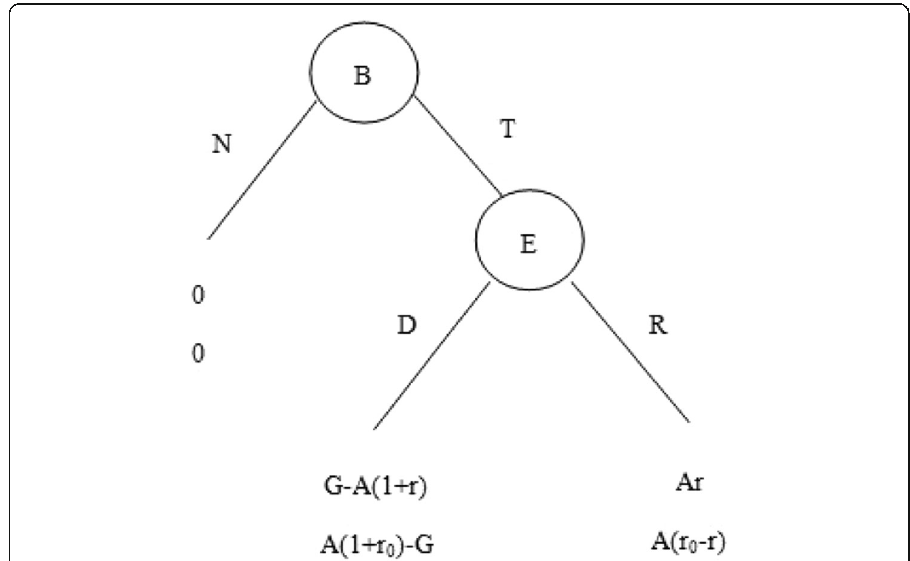
Fig. 1 The credit game between bank and small business. Note: B stands for bank, and E stands for small business. Distrust (N) and trust (T) are two behavioural strategies for bank, namely granting loans to small business or not. Default (D) and respect (R) are two strategies for small business, namely repaying the loans fully or not. A is the loan size, r is the lending rate, r0 notes the rate of return small business receives from the investment with the loan and r0>r holds, G is the monetary value of collateral pledged by small business for the loan. Due to the imperfect liquidity of the collateral, its possible monetary payoff available for bank after small business takes the strategy of D is negative, i.e.